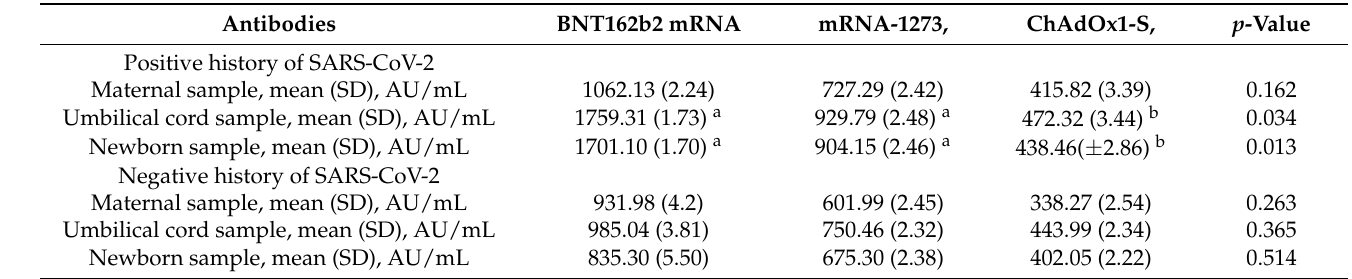
Table 4. Comparison between homologous vaccination schedules with maternal history of SARS-CoV-2.